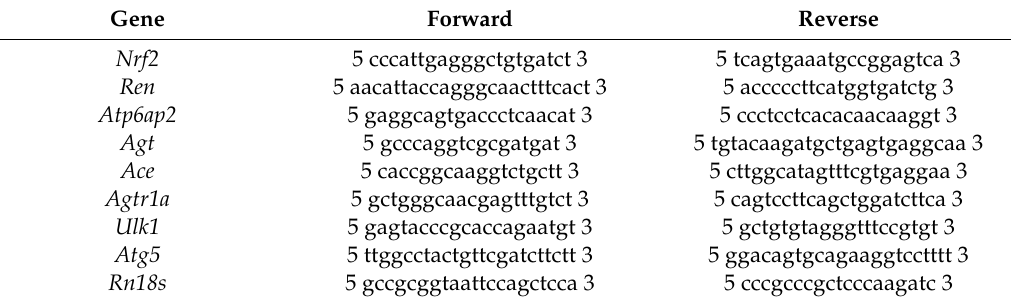
Table 3. Quantitative real-time polymerase chain reaction primers